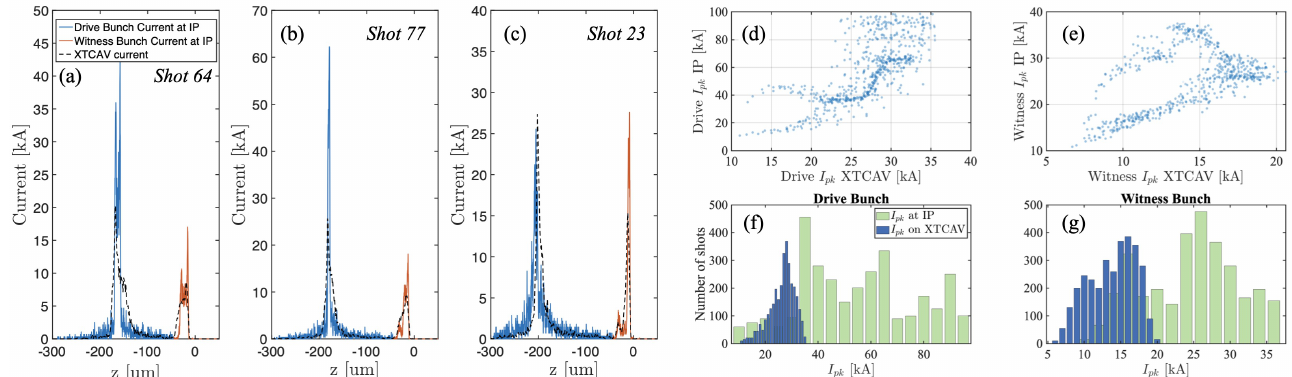
Figure 3. ( a – e ) Single shot comparisons of the current profiles obtained from the simulated TCAV images and those calculated directly from the macroparticle distribution in simulation dumped at the IP. The shots match those displayed in ( f , g ) Comparison of the peak current measured by the TCAV vs. at the IP for the drive and witness beam. The plots show that the TCAV measurement underestimates the peak current value and smears out some details of the current distribution for the very short bunches that will be produced at